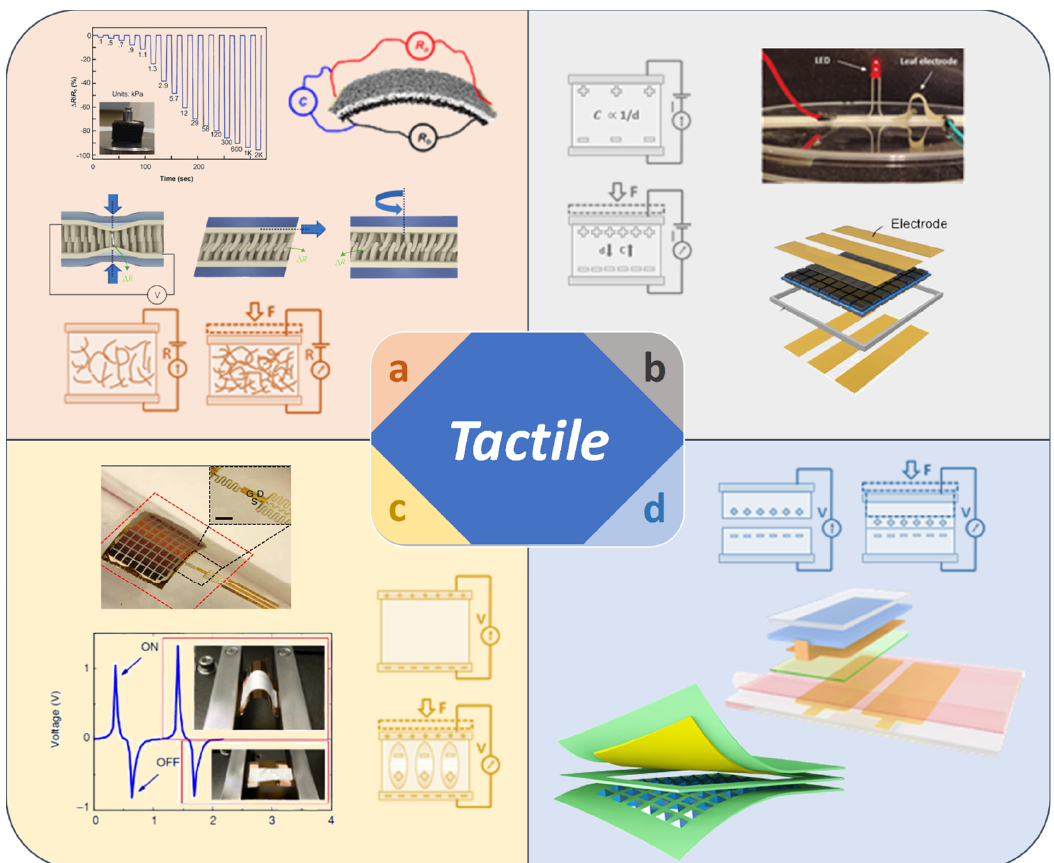
Figure 1. Working mechanism of different tactile sensors: ( a ) piezoresistive effect; ( b ) piezocapacitive effect; ( c ) piezoelectric effect; ( d ) triboelectric effect.